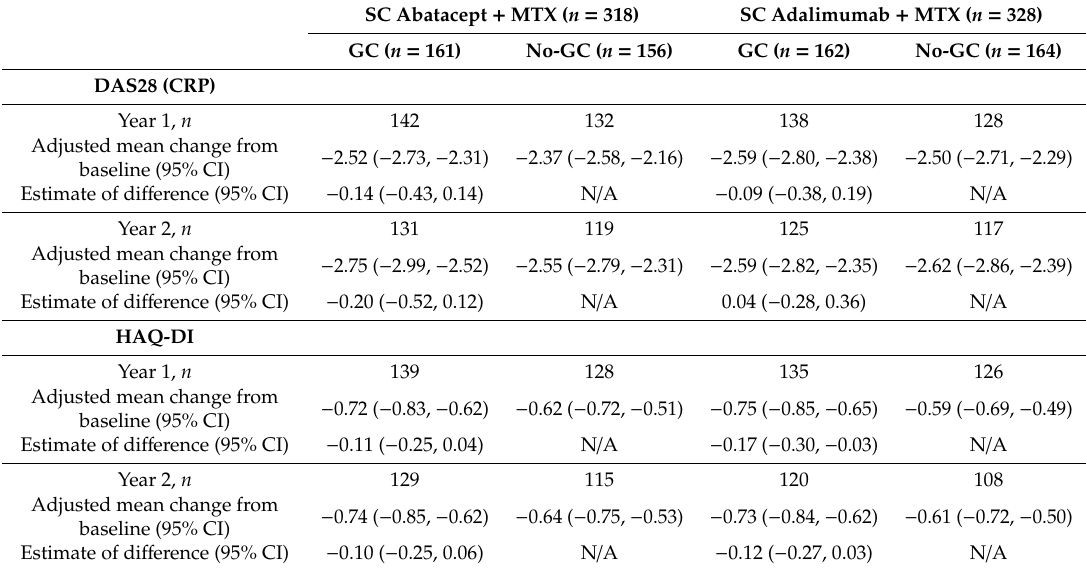
Table A1. Adjusted mean change from baseline in DAS28 (CRP) and HAQ-DI at Years 1 and 2 a